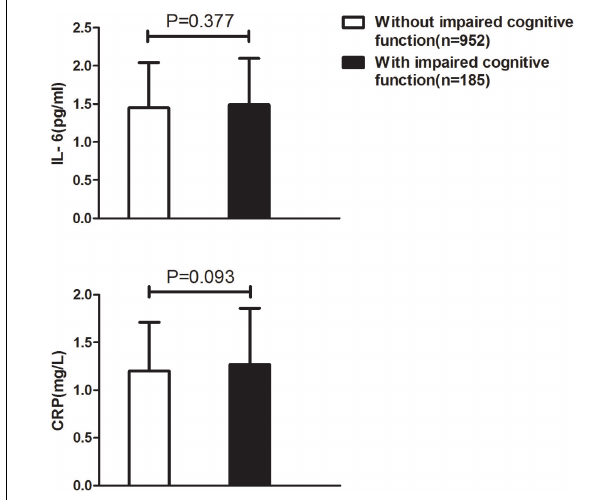
FIGURE 1 | Comparisons of inflammation markers between participants with impaired cognitive function and those without impaired cognitive function after excluding subjects with cardiovascular diseases.